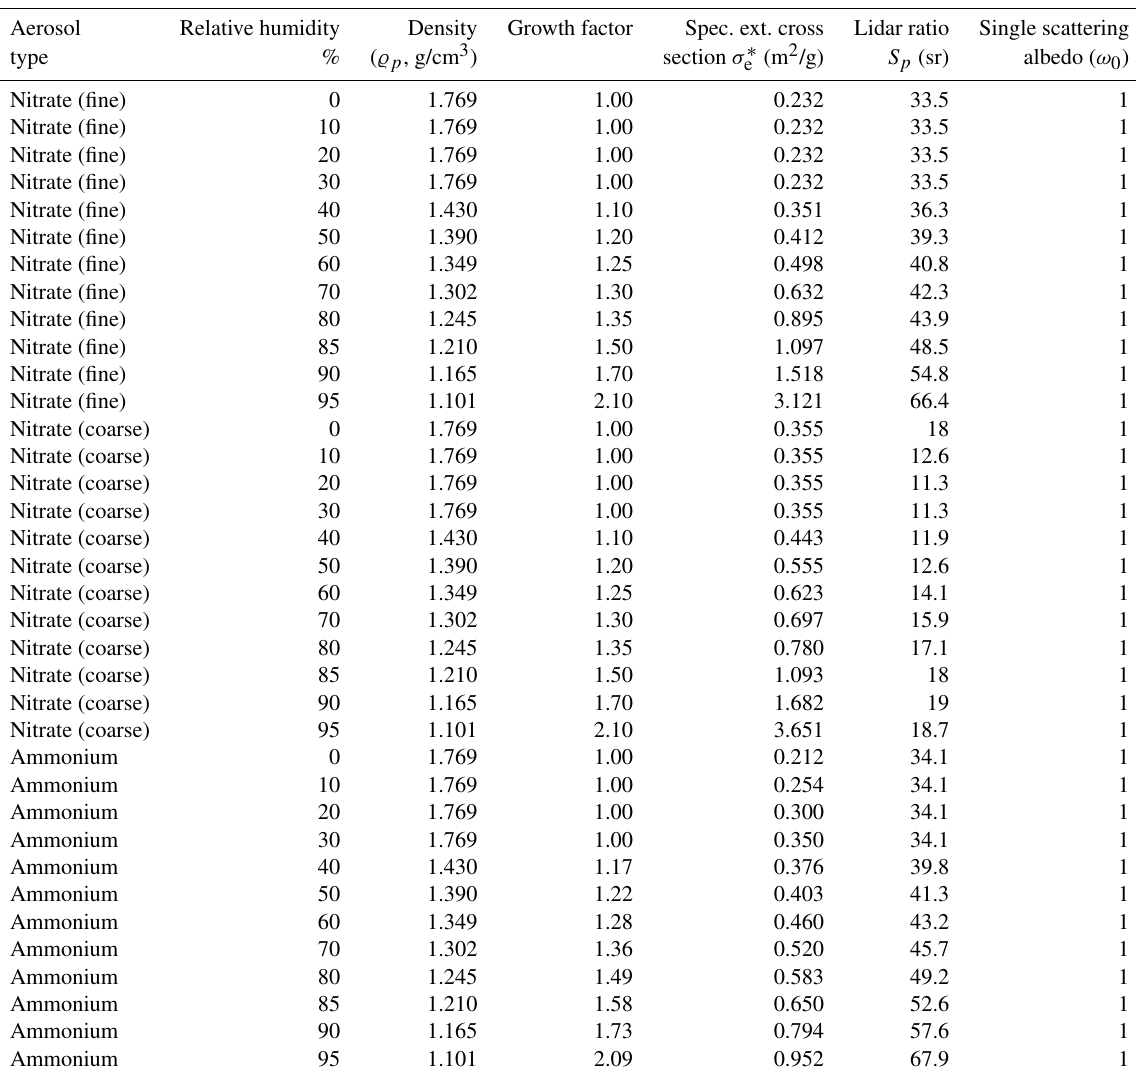
Table C3. Microphysical properties of aerosols assumed for conversion of model mass mixing ratios to β ∗ (z) at 1064nm. Aerosol Relative humidity Density Growth factor Spec. ext. cross Lidar ratio Single scattering